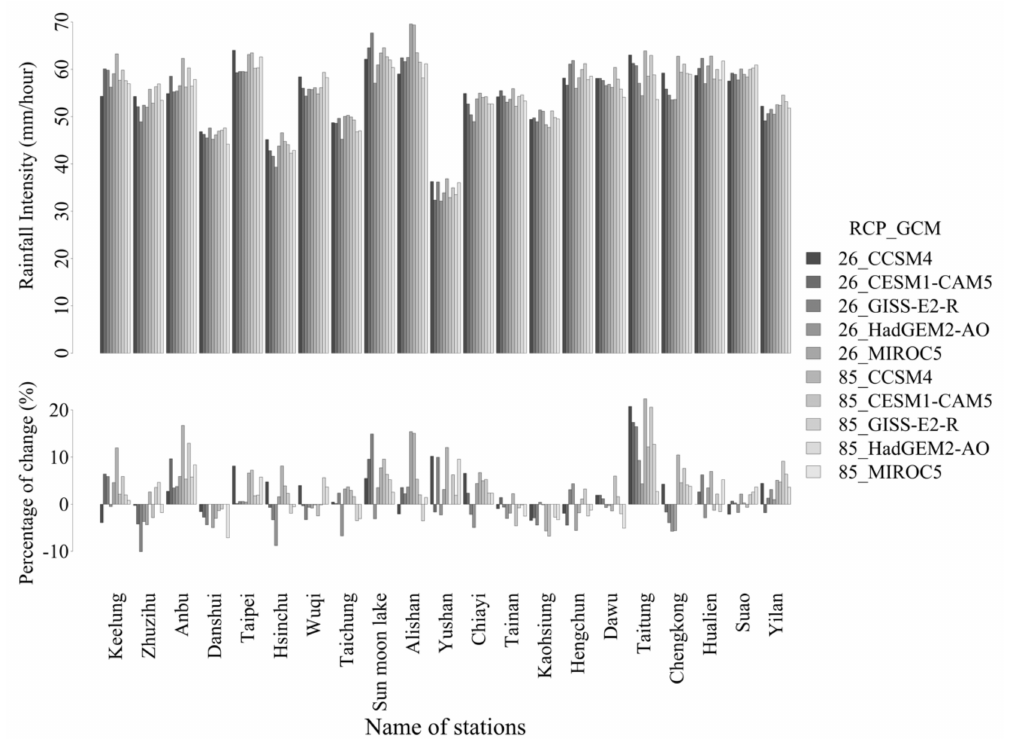
Figure 5. Rainfall intensities ( top ) and percentage of changes ( bottom ) of events with one-hour duration and two-year return period (events short ) for far future (2081–2100) under RCP2.6 and RCP 8.5 for five GCMs (CCSM4, CESM1-CAM5, GISS-E2-R, HadGEM2-AO,